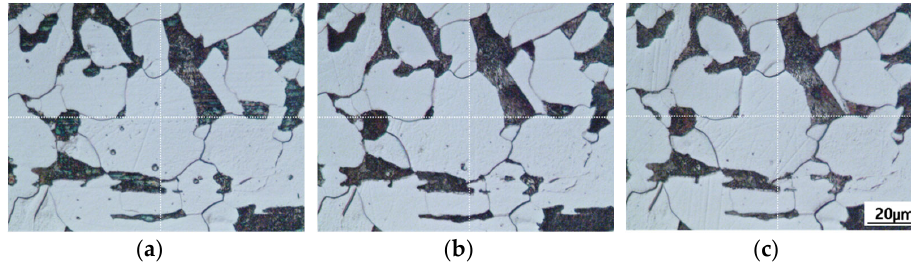
Figure 2. Microscopic photograph of the polished layers. ( a ) 3rd layer; ( b ) 4th layer; and ( c ) 5th layer.